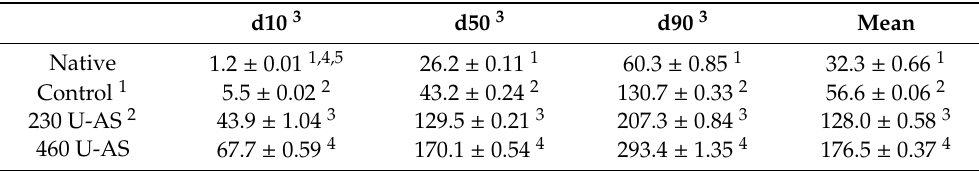
Table 1. Particle sizes of waxy corn starch treated with amylosucrase